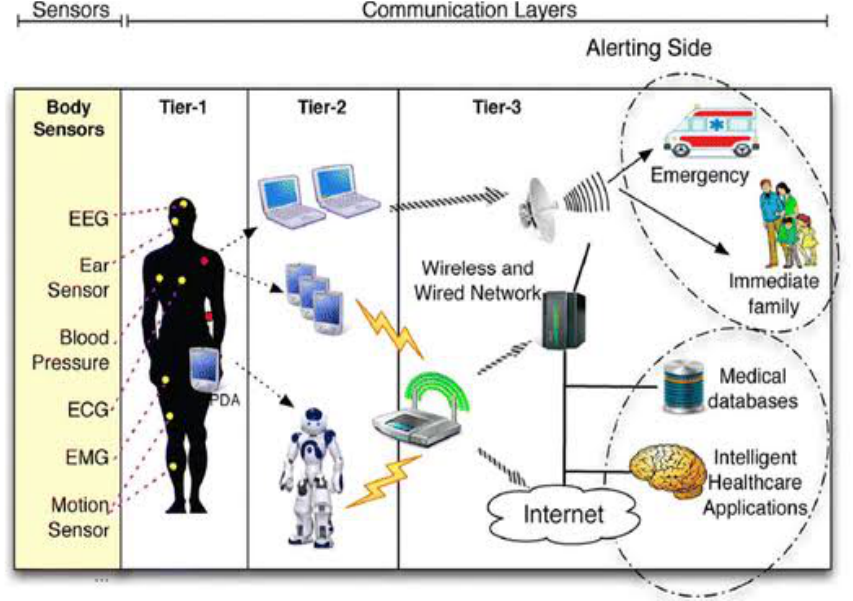
Figure 5. Telemedicine system utilizing